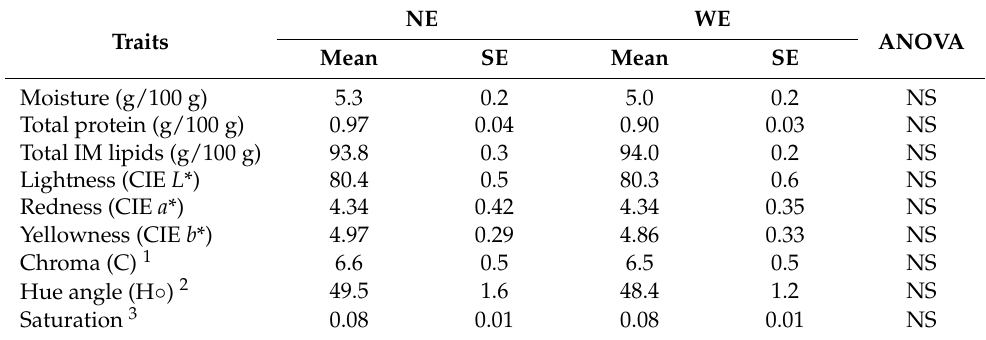
Table 9. Physical-chemical composition of dorsal subcutaneous fat from Alentejano pigs kept on individual pens without exercise area (NE, n = 9) or outdoors with exercise area (WE, n = 9) from ~87 to 160 kg